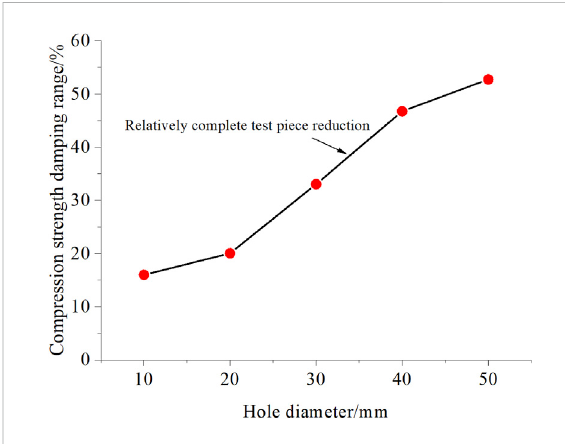
FIGURE 7 Relationship between the hole diameter and compression strength damping range.